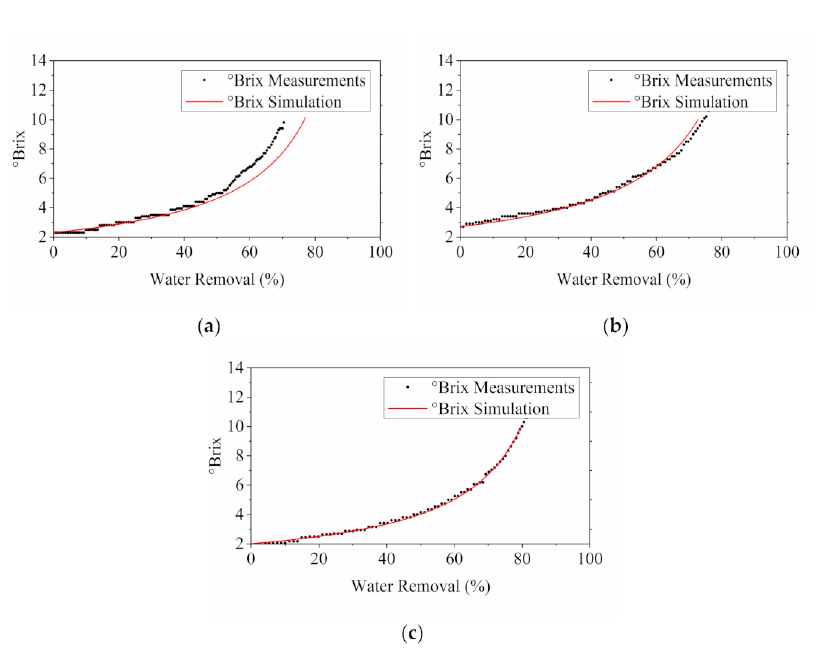
Figure 10. Comparison of ◦ Brix results obtained from simulation with experimental ◦ Brix measure- ments taken during MD processes with various operating feed temperatures: ( a ) 50 ◦ C; ( b ) 55 ◦ C; and ( c ) 60 ◦